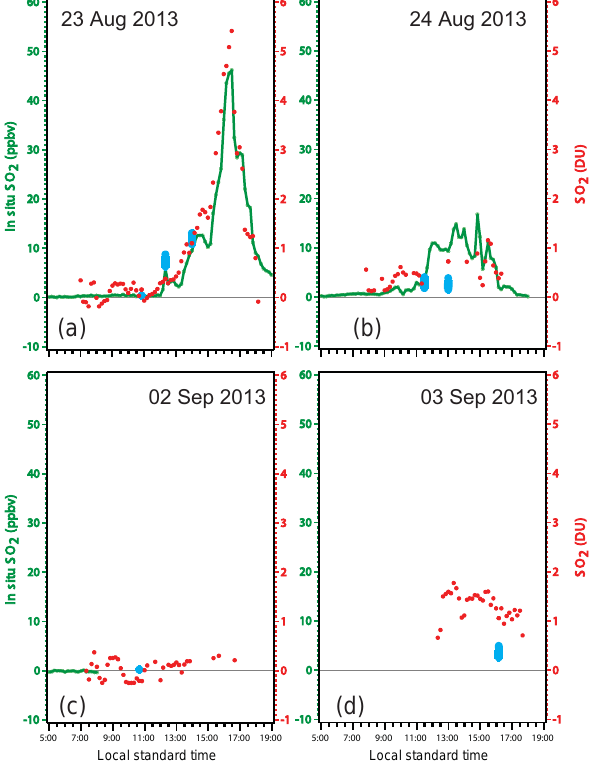
Figure 11. SO 2 VCD (DU) measured by the Pandora spectrome- ter (red) at Fort McKay and calculated from integrated aircraft SO 2 profile measurements (blue), as well as in situ SO 2 concentration in ppbv (green). The vertical blue bars represent the range of SO 2 VCDs calculated from two assumptions: for 0 mixing below the lowest aircraft flight height and a constant mixing ratio that corre- sponds to the mixing ratio at the lowest altitude where SO 2 was measured.